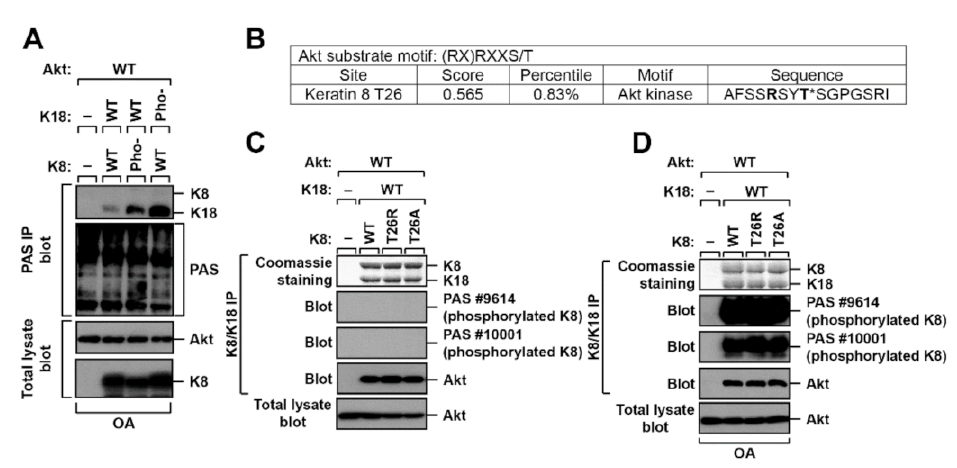
Figure 2. K8/K18 are potential substrates of Akt. ( A ) A K8 or K18 phosphorylation-deficient mutant was transfected into BHK-21 cells, and the cells were treated with OA for 2 h. The transfected cells were immunoprecipitated against phosphorylated Akt substrate (PAS) antibodies followed by immunoblotting with K8/K18. ( B ) The Akt substrate motif was analyzed in K8 protein sequences by Scansite (scansite4.mit.edu). K8 T26 was shown as a potential Akt substrate. ( C , D ) BHK-21 cells were transfected with K8 WT, T26R, or T26A together with K18 WT and Akt WT and then cultured under basal ( C ) or OA treatment ( D ) conditions. The cells were immunoprecipitated against K8/K18, and then the immunoprecipitates were immunoblotted with PAS antibodies. Each PAS antibody detects the following consensus sequence: PAS #9614, RXXpS/pT; PAS #10001,